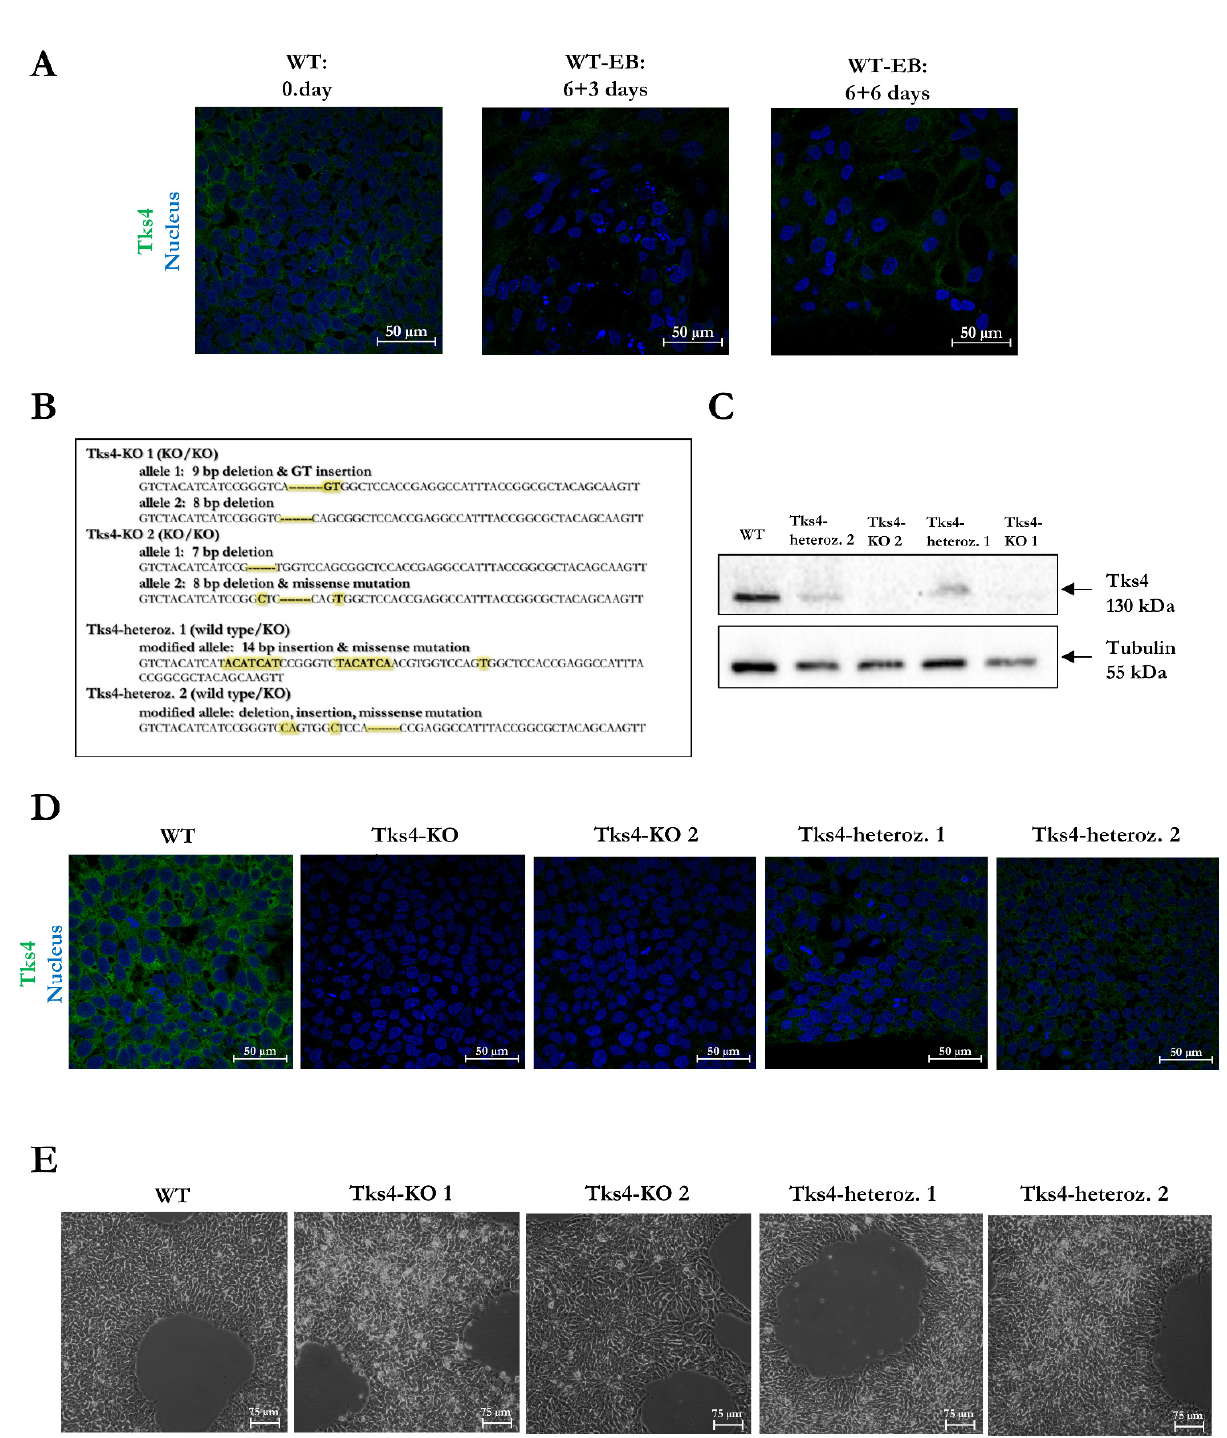
Figure 1. Generation of Tks4-knockout HUES9 cells. ( A ) Representative confocal images showing the typical immunostaining for Tks4 during spontaneous differentiation via EB formation in HUES9 cells; ( B ) Sequence of exon 2 of SH3PXD2b in the two newly generated homozygous-mutated (KO/KO) clones and the two heterozygous clones (WT/KO). The mutant nucleotides are labelled with yellow marker in the region of interest of the sequenced allele. Validation of Tks4 loss at the protein level in the two Tks4-KO HUES9 clones in comparison with the original HUES9 and heterozygous cells using ( C ) western blotting and ( D ) immunocytochemistry (ICC): Tks4—green, nucleus—blue (DAPI); ( E ) Representative bright field images showing that all of the cell lines retain human ESC morphology (scale bar 75 µ